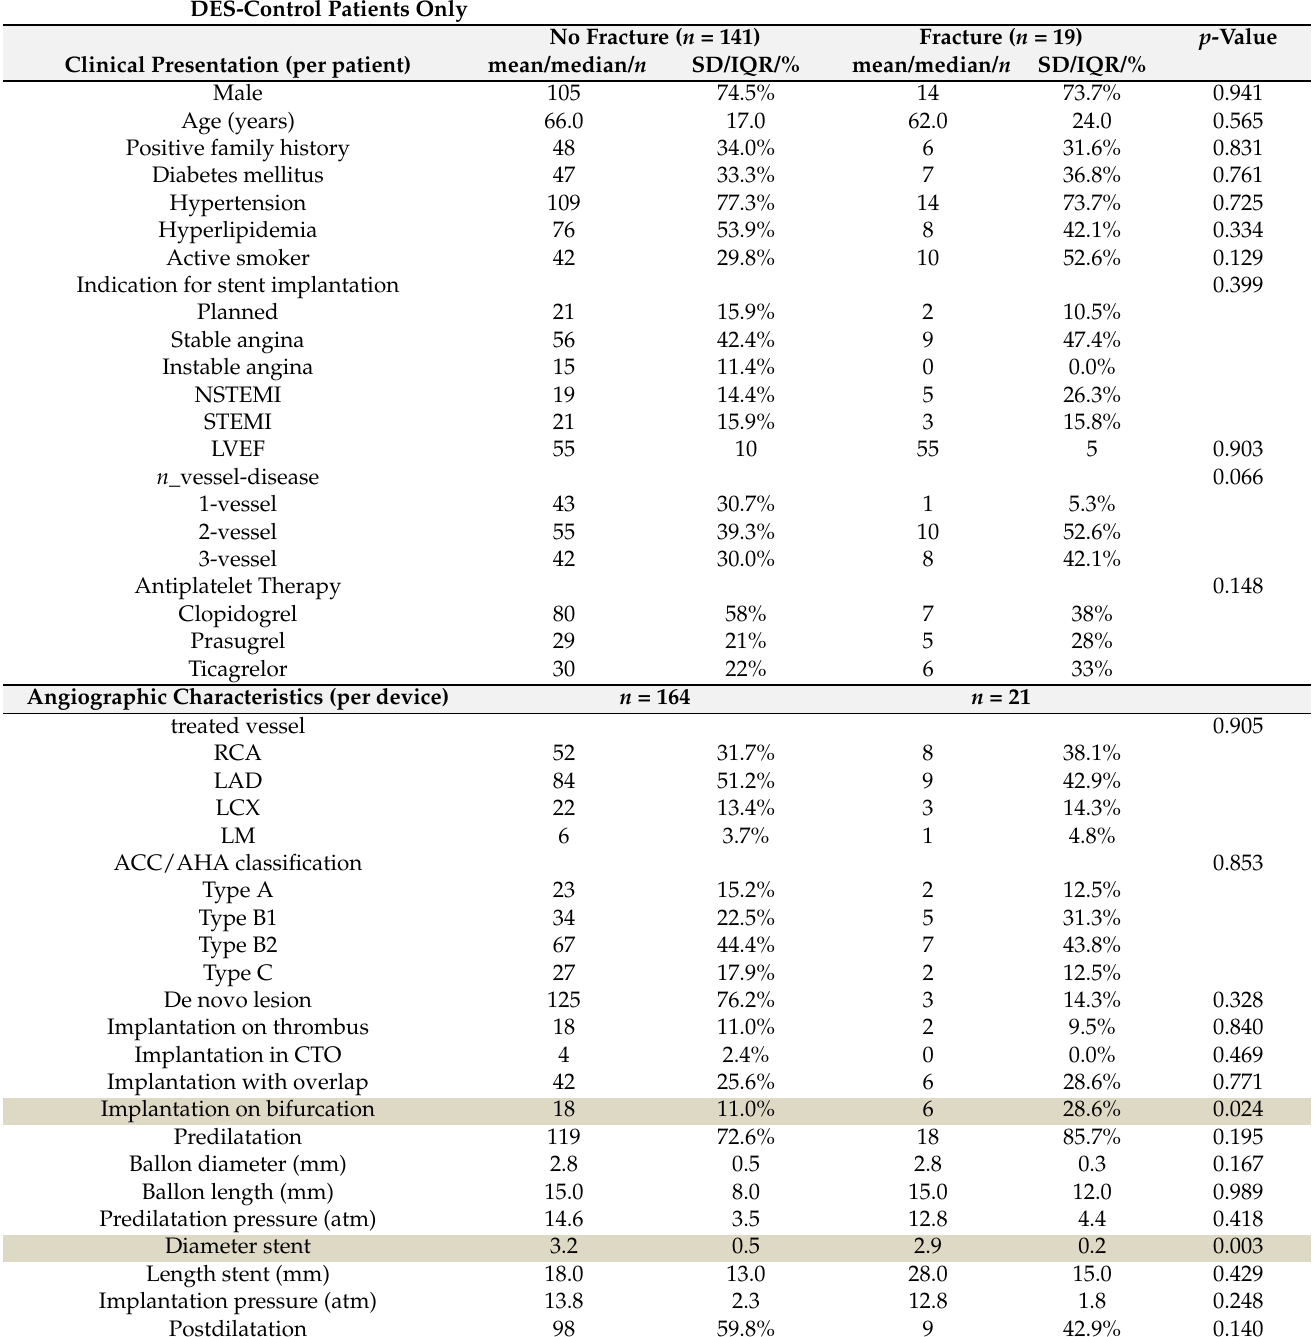
Table 1. Patient